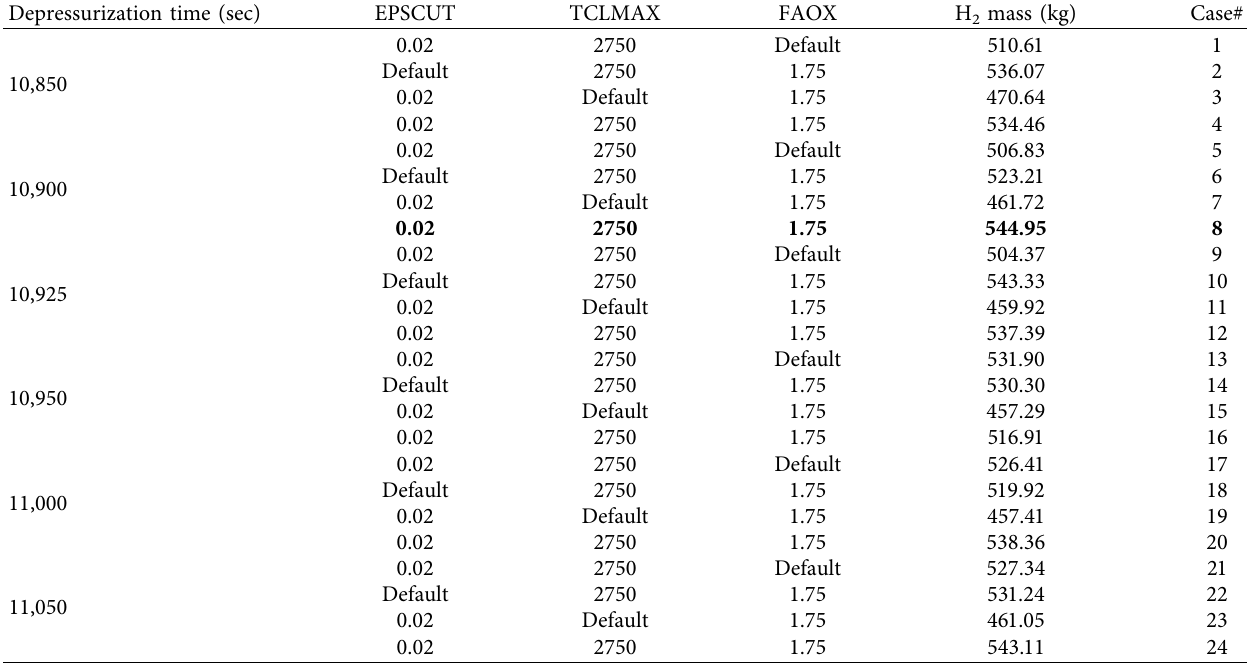
Table 13: Results of sensitivity study #5 (MAAP parameter, base case).